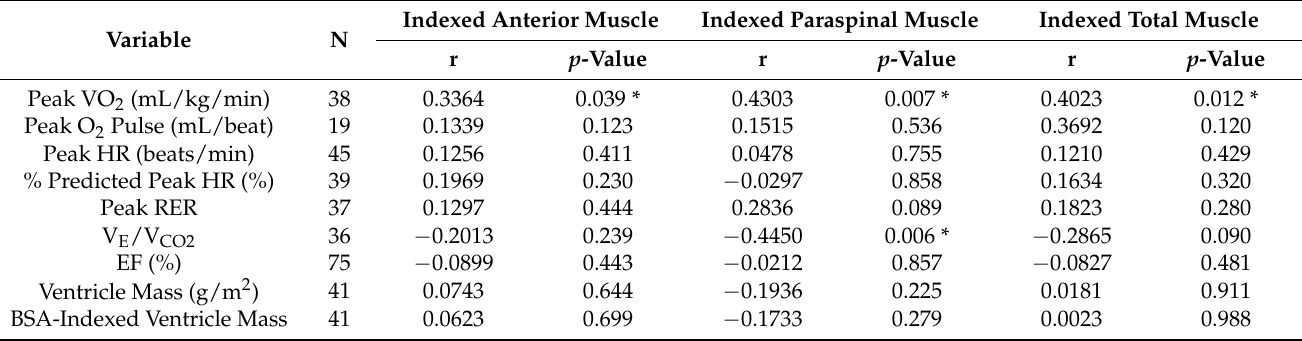
Table 4. Anterior and paraspinal muscle correlations.